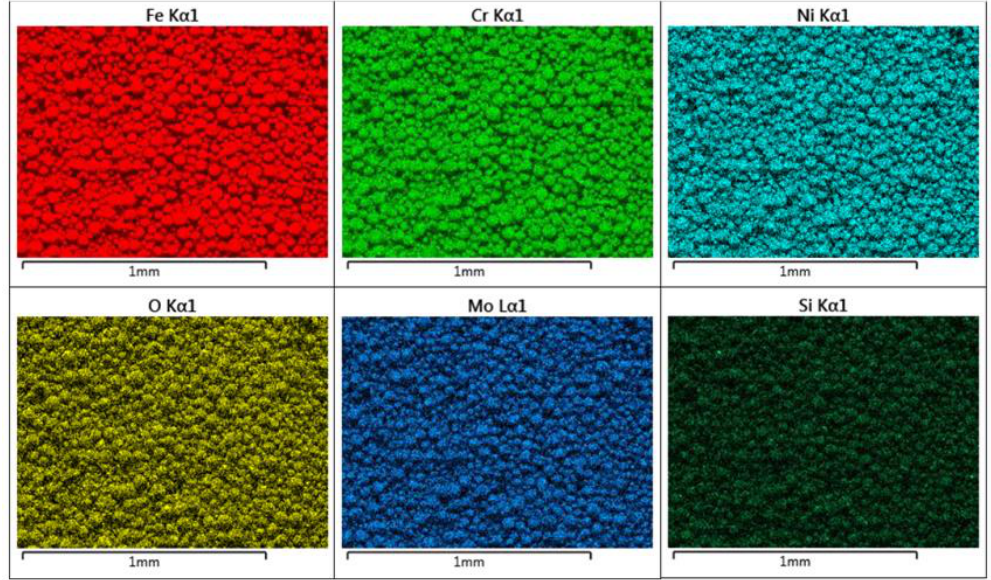
Figure 10. SEM EDX images showing elemental compositions for powder A. The elemental distribution appears very homogeneous. Table 4. Elemental composition of powder A measured by EDX. Values are expressed as counts-per- second/electronvolt (cps/eV).